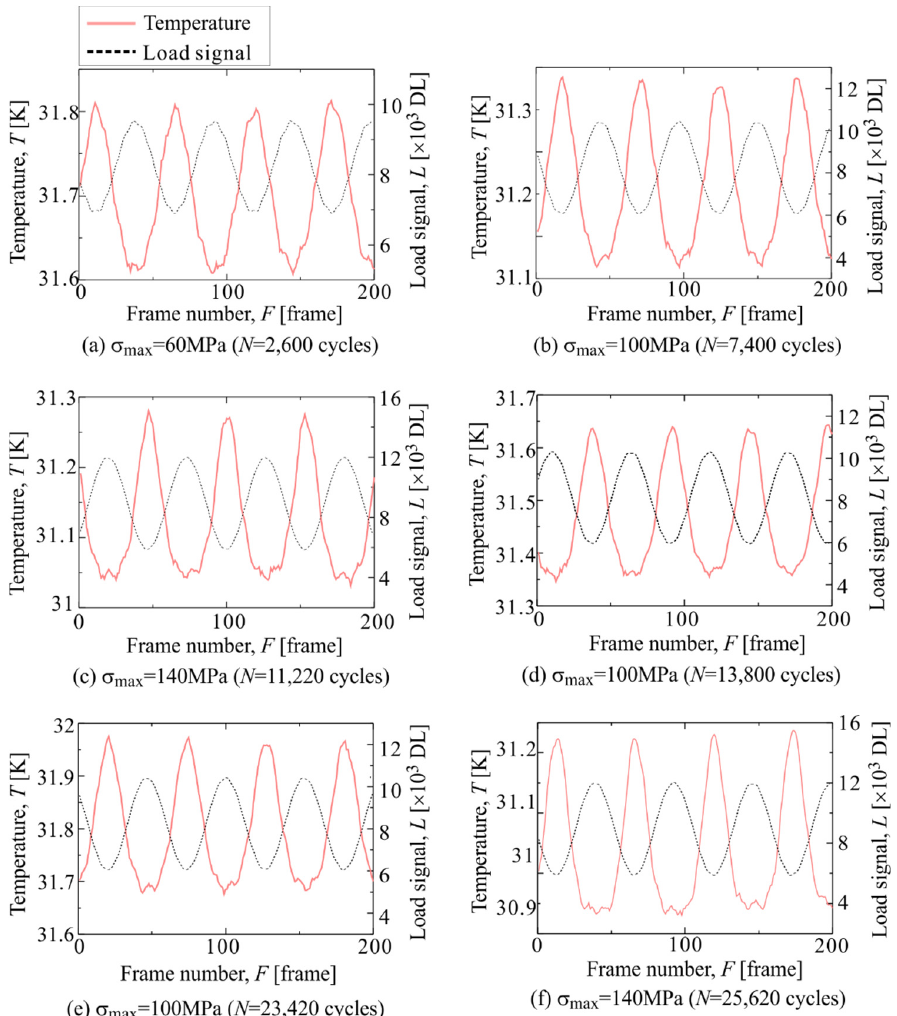
Figure 15. Change in mean temperature and load signal in Area c-2 measured at ( a ) σ max = 60 MPa and N = 2600 cycles, ( b ) σ max = 100 MPa and N = 7400 cycles, ( c ) σ max = 140 MPa and N = 11,200 cy- cles, ( d ) σ max = 100 MPa and N = 13,800 cycles, ( e ) σ max = 100 MPa and N = 23,420 cycles and ( f ) σ max = 140 MPa and N = 25,620 cycles.